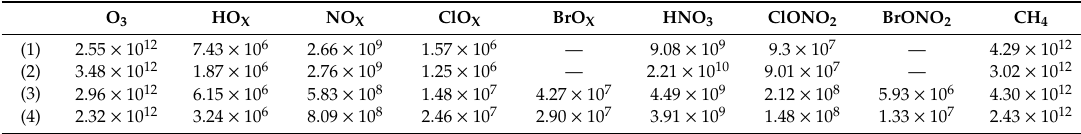
Table 3. Comparison of the simulation results from di ff erent models.